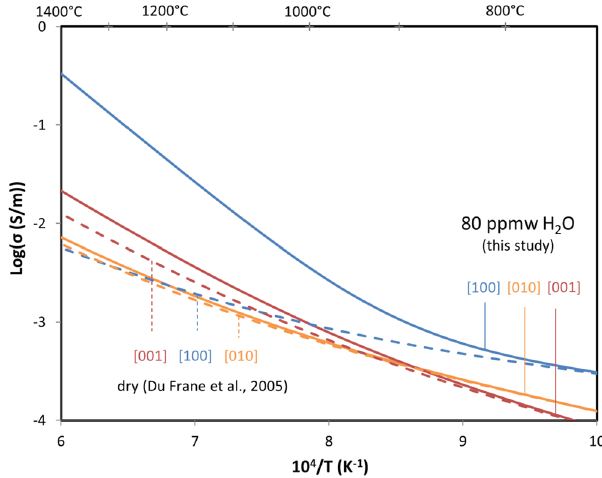
Figure 4. Total electrical conductivity of olivine as a function of inverse temperature (in Kelvin). Data for dry olivine 36 along the three principal orientations are displayed by dashed lines while the calculated value for hydrous olivine (80 ppm wt H 2 O) are shown by blue ([100]), orange ([010]) and red ([001]) solid lines. Temperatures in degrees °C are also shown at the top of the